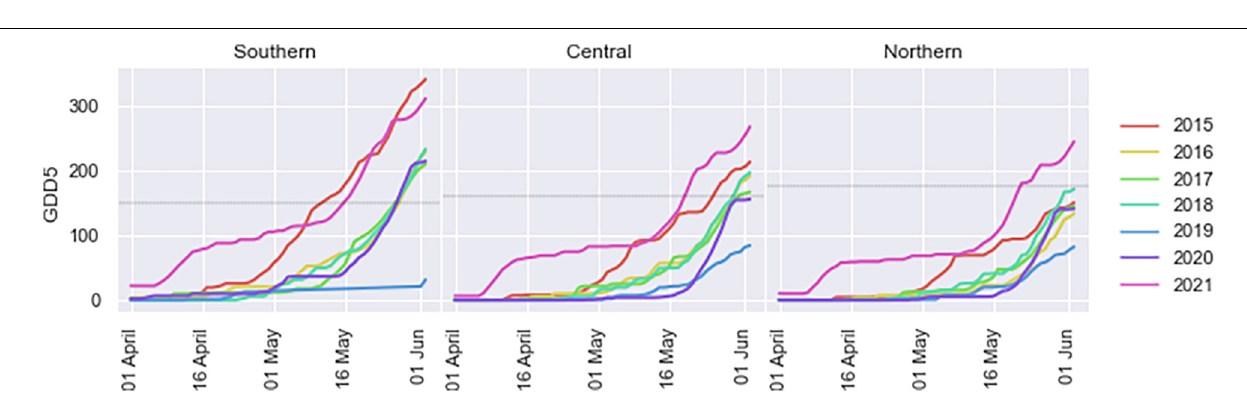
FIGURE 3 | Daily maximum and minimum temperatures recorded at the nearest weather station from May 1st to June 15th 2021 for the three plantation sites.